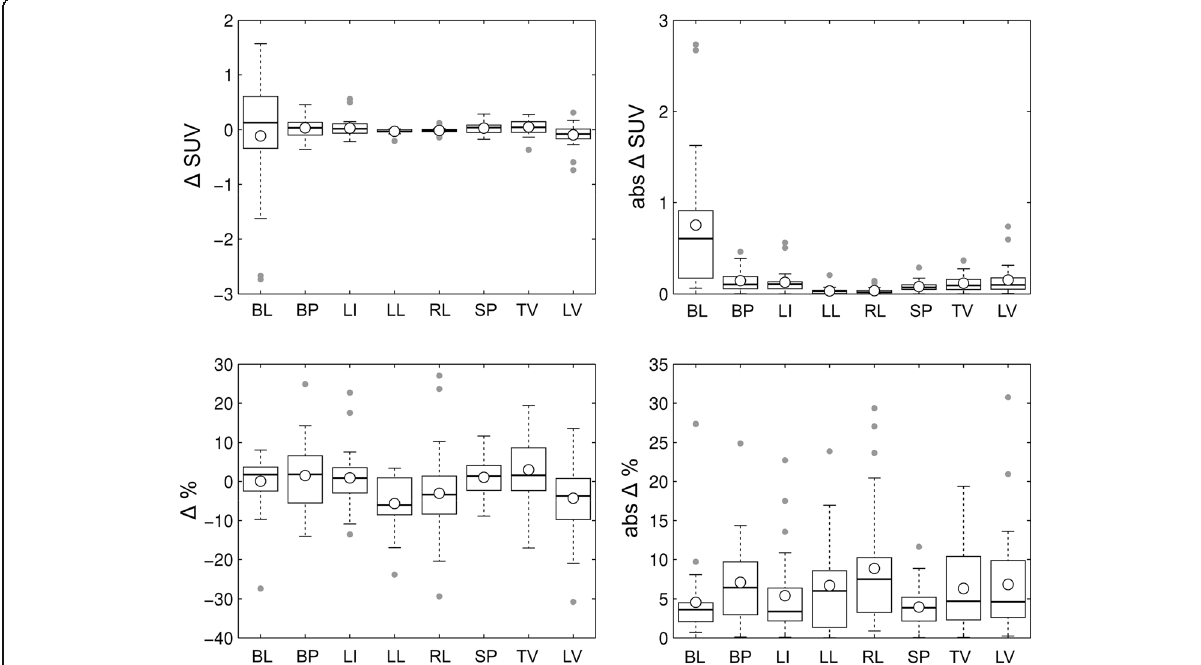
Fig. 5 Deviation (upper left), absolute deviation (upper right), percent deviation (lower left), and absolute percent deviation (lower right) of SUVs in anatomic structures on PET GAN compared to PET AC . (BL, urinary bladder; BP, blood pool; LI, liver; LL, left lung; RL, right lung; SP, spleen; TV, thoracic vertebra; LV, lumbar vertebra)